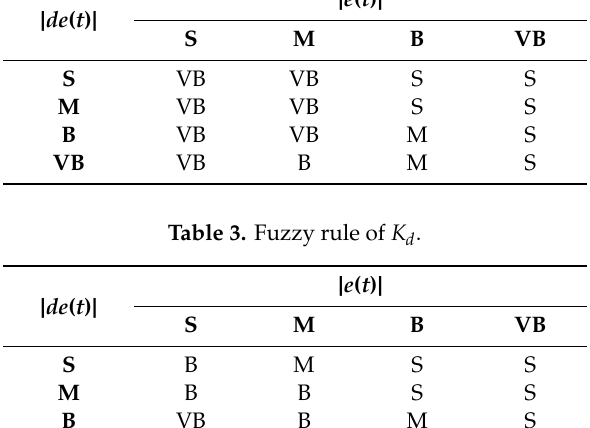
Table 2. Fuzzy rule of K i .